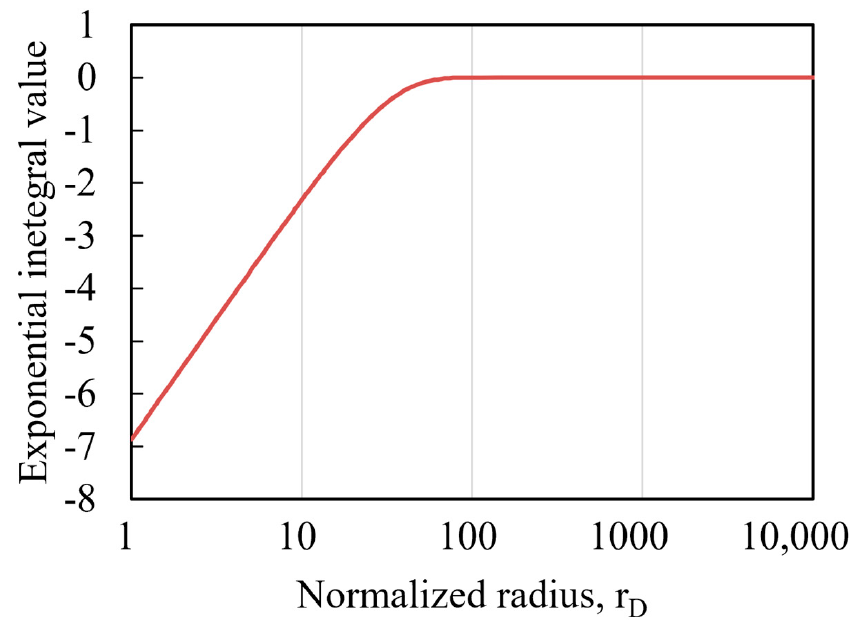
Figure 5. Exponential integral value throughout the reservoir